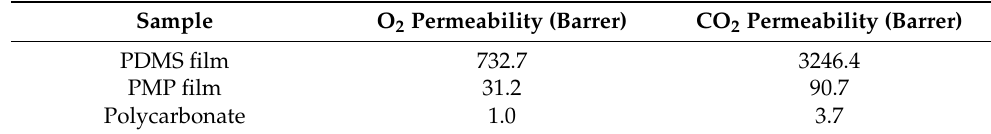
Table 1. Measured O 2 and CO 2